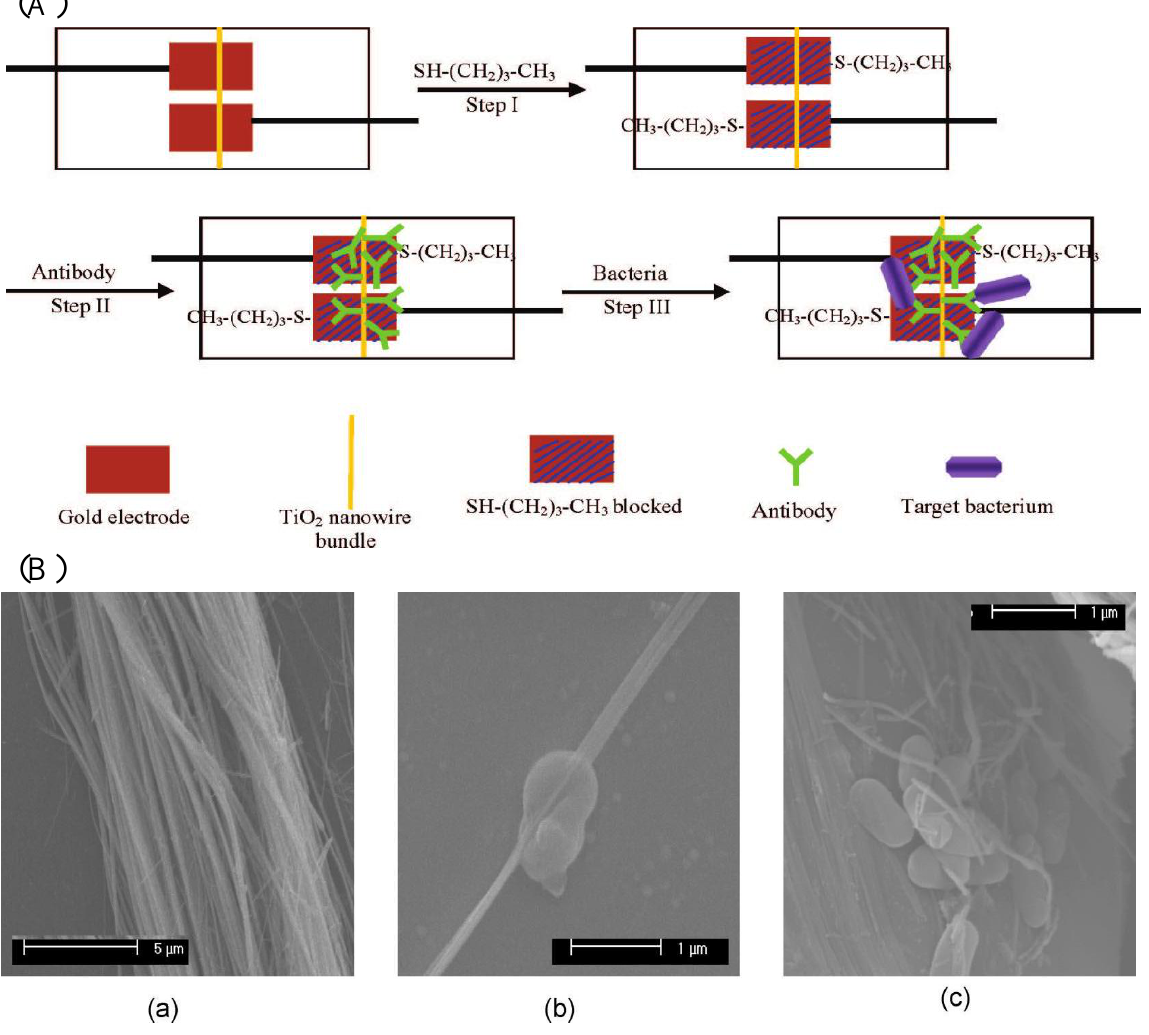
Figure 4. ( A ) Principle of TiO nanowire bundle microelectrode based impedance 2 immunosensor for the detection of bacteria. ( B ) SEM micrographs of TiO bundle ( a ) before (5,000×) and ( b , c ) after binding with Listeria innocua (20,000×)